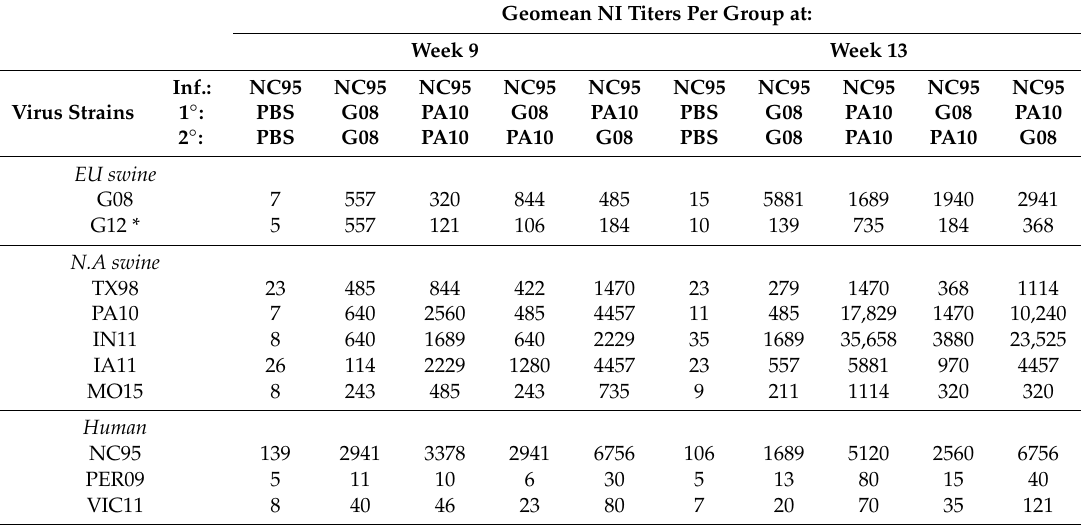
Table4. MeanNIantibodytitersagainstH3N2influenzastrainsusedforimmunizationandantigenically distinct N2 strains in pigs of di ff erent vaccine groups. Geomean NI Titers Per Group at: Week